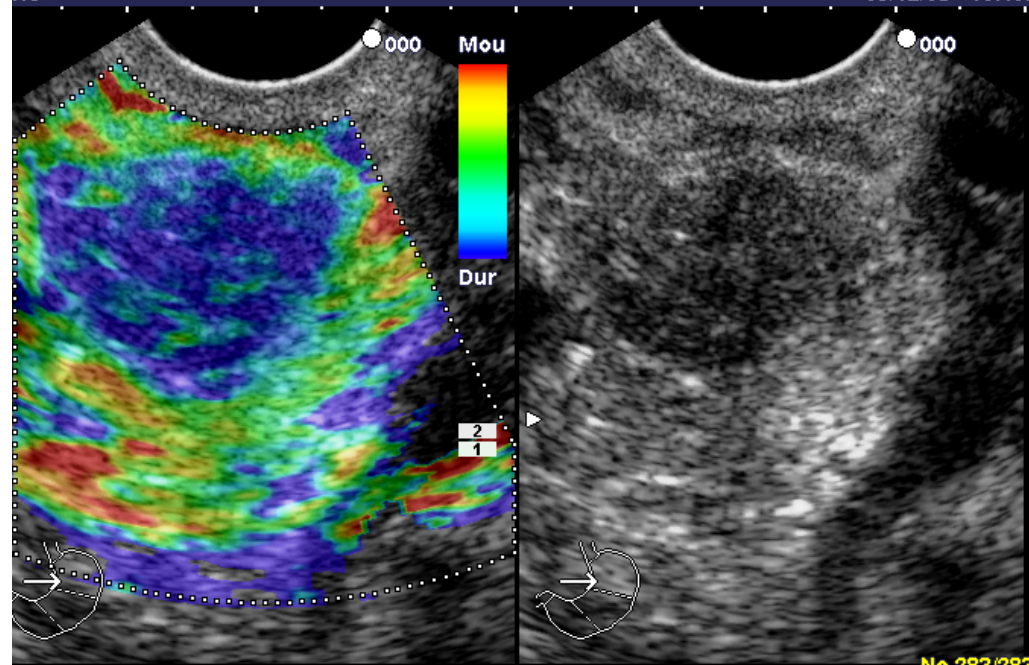
FIGURE 13. Score 3: small adenocarcinoma of the